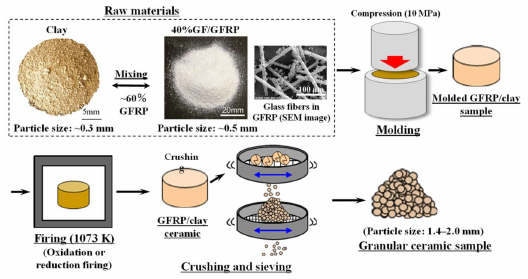
Figure 1. The manufacturing process of GFRP/clay ceramic samples.